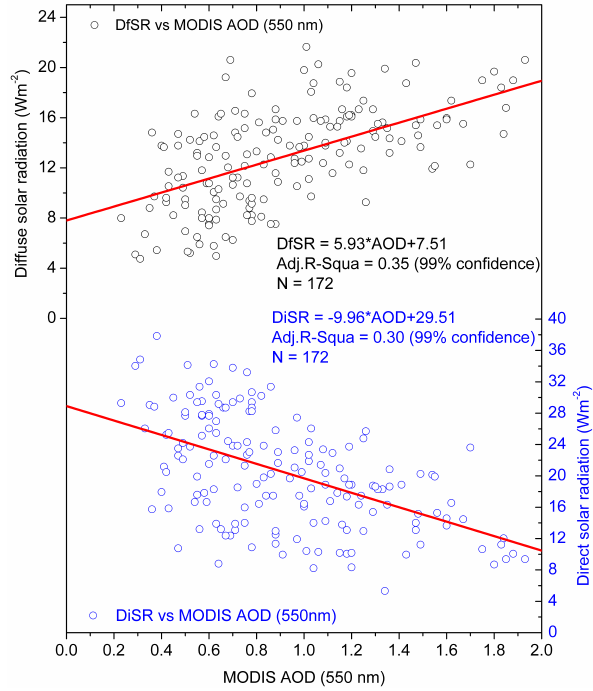
Fig. 3. Scatter plots of AOD and DfSR (denoted by black cycles on the top) and DiSR (denoted by blue cycles on the bottom) measured in spring from 2004 to 2007 in Shanghai. The AOD data is from the daily level 2 MODIS Aqua and Terra products (collection 005) at 550nm. The DiSR and DfSR were measured during the satellite passage over this area. Linear fittings are red lines.